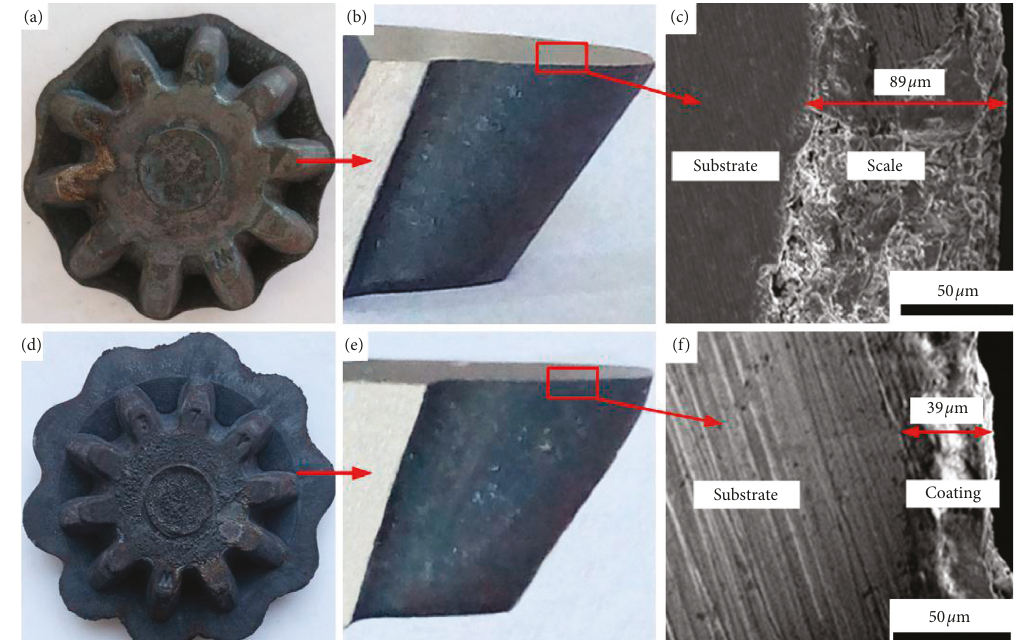
Figure 5: Bevel gears showing the (a) uncoated gear, (b) uncoated teeth, (c) cross section of uncoated gear forgings, (d) coated gear, (e) coated teeth, and (f) cross section of coated gear